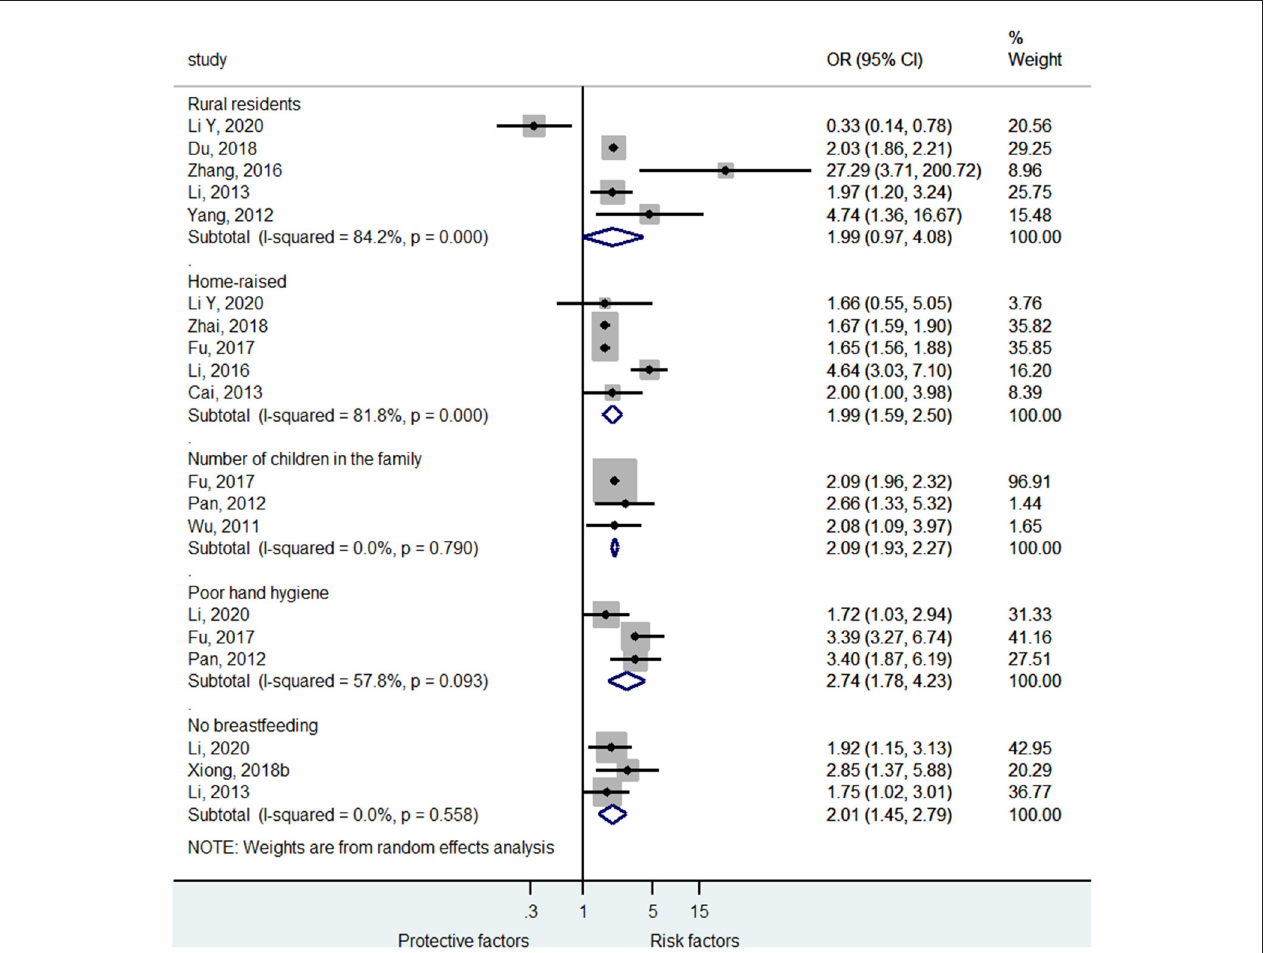
FIGURE 4 | Forest plot for the association of lifestyle of life habits with severe hand foot mouth